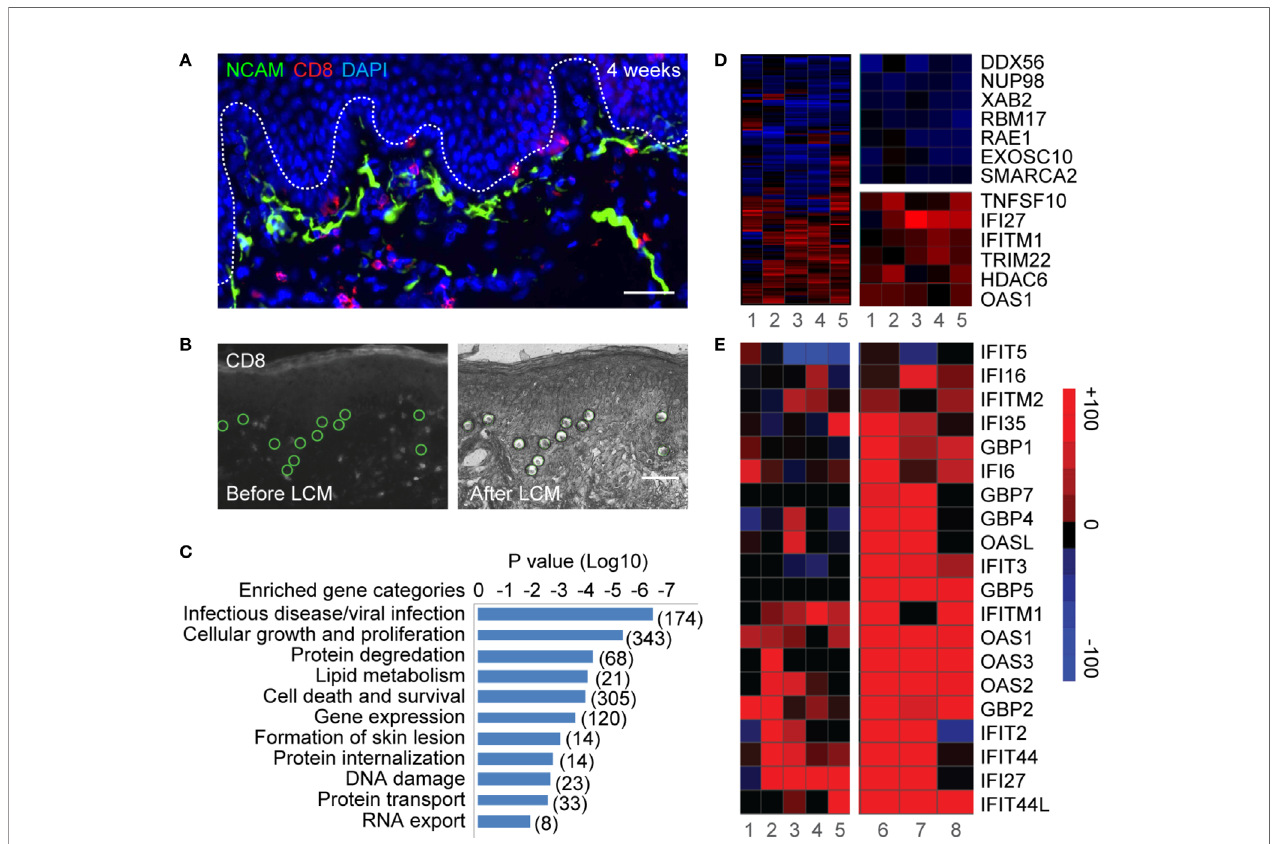
FIGURE 1 | Laser capture microdissection and transcriptional pro fi ling of keratinocytes neighboring CD8TRM in human genital HSV-2 reactivation. (A) Innervating nerve endings (green) and CD8 + T cells (red) are interconnected with basal keratinocytes at dermal-epidermal junction (DEJ) in a human genital skin biopsy obtained 4 weeks post-healing. Scale bar, 50 µm. (B) Micrographs depicting selection (left) and isolation (right) of individual basal keratinocytes in the vicinity of DEJ CD8TRM cells using laser capture microdissection. Scale bar, 50 µm. (C) Signi fi cantly enriched functional categories of differentially expressed genes in keratinocytes isolated from n = 5 post-healing biopsies compared to matched controls. (D) Hierarchical clustering of a set of 174 genes annotated to infectious disease/viral infection (left). Down-regulated genes involved in RNA transcription, processing and transportation (right top) and up-regulated genes annotated to interferon and antiviral responses (right bottom). (E) Up-regulation of a subset of ISGs in keratinocytes isolated from post healing skin (n = 5, samples 1-5) and matched HSV-2 lesion (n = 3, samples